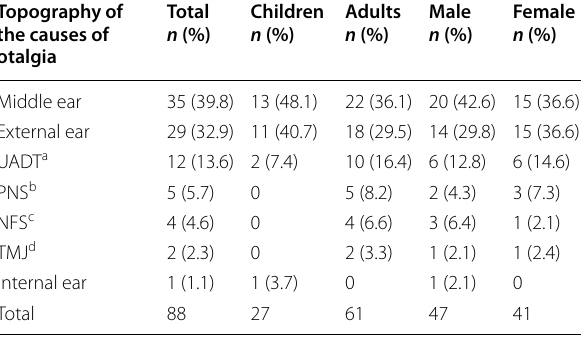
Table 3 Topographical distribution of otalgia aetiologies according to age group and